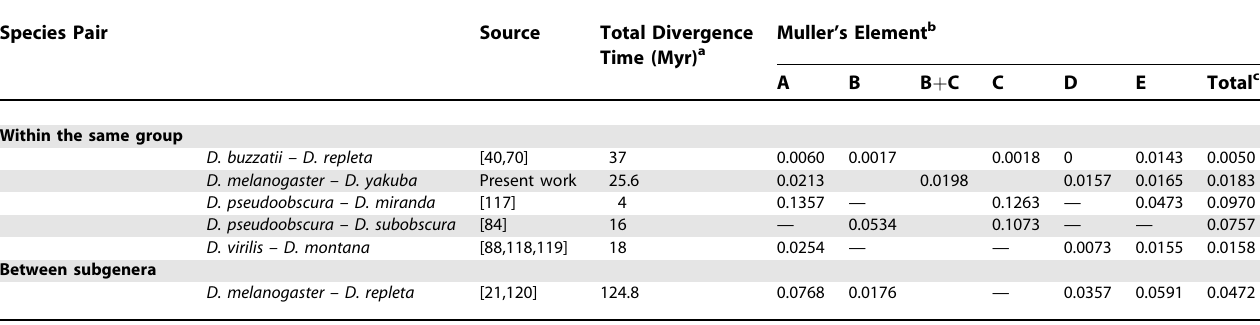
Table 4. Rates of Chromosomal Evolution (Breakpoints/Mb/Myr) between Different Species Pairs of the Genus Drosophila Species Pair